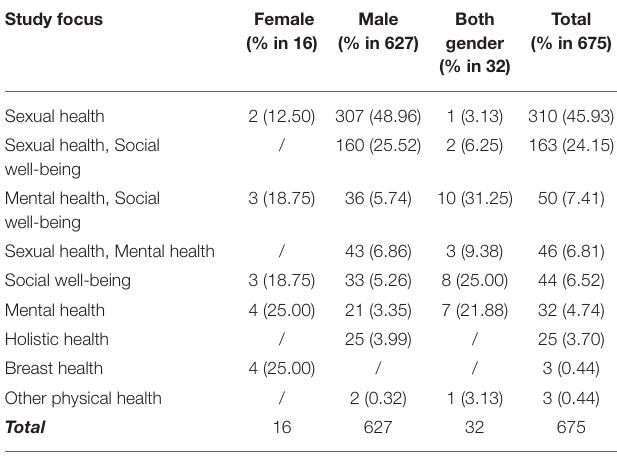
TABLE 6 | Study focus and gender differences in 675 studies published in